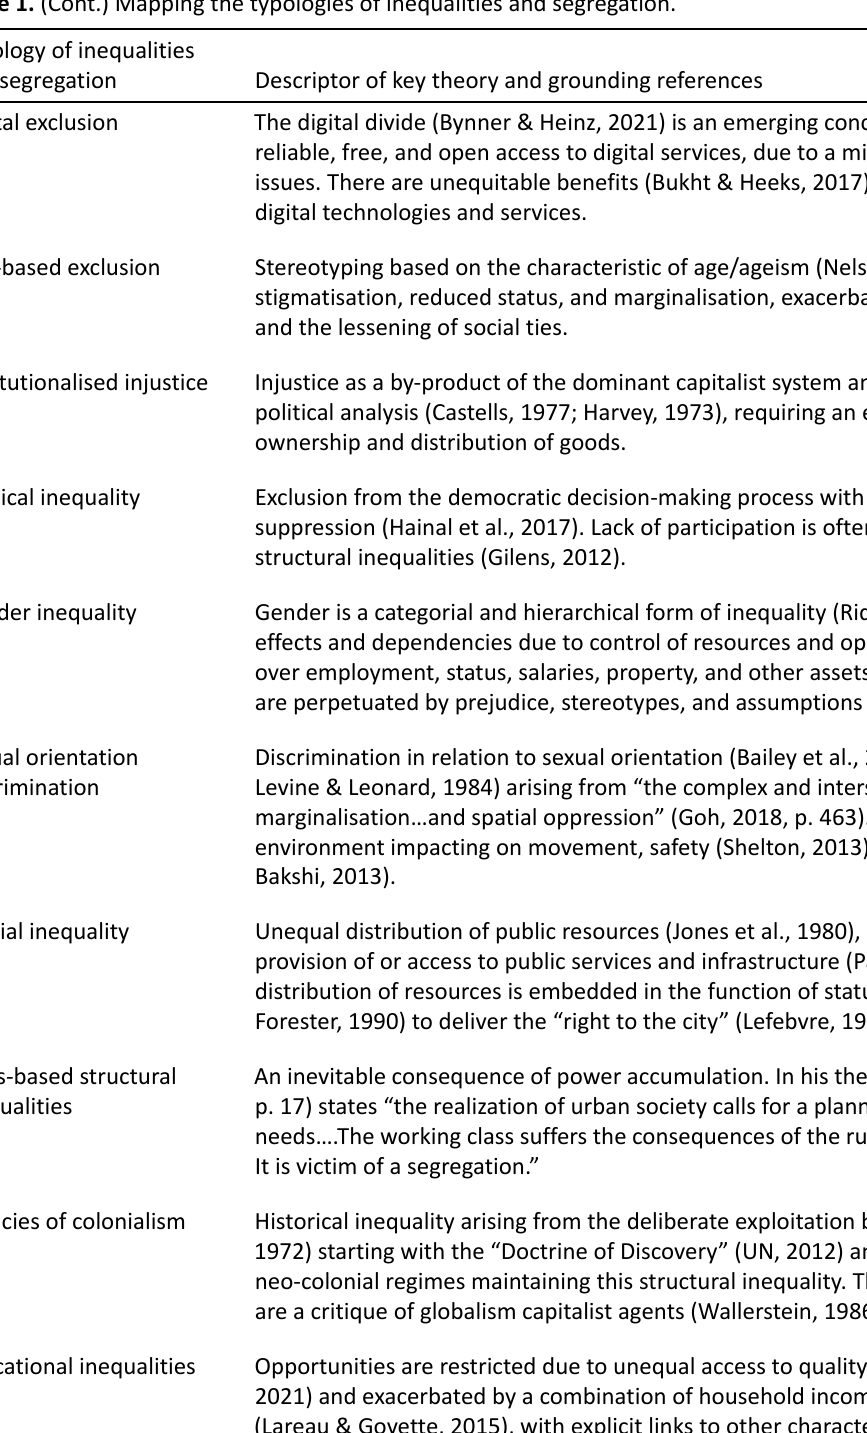
Table 1. (Cont.) Mapping the typologies of inequalities and